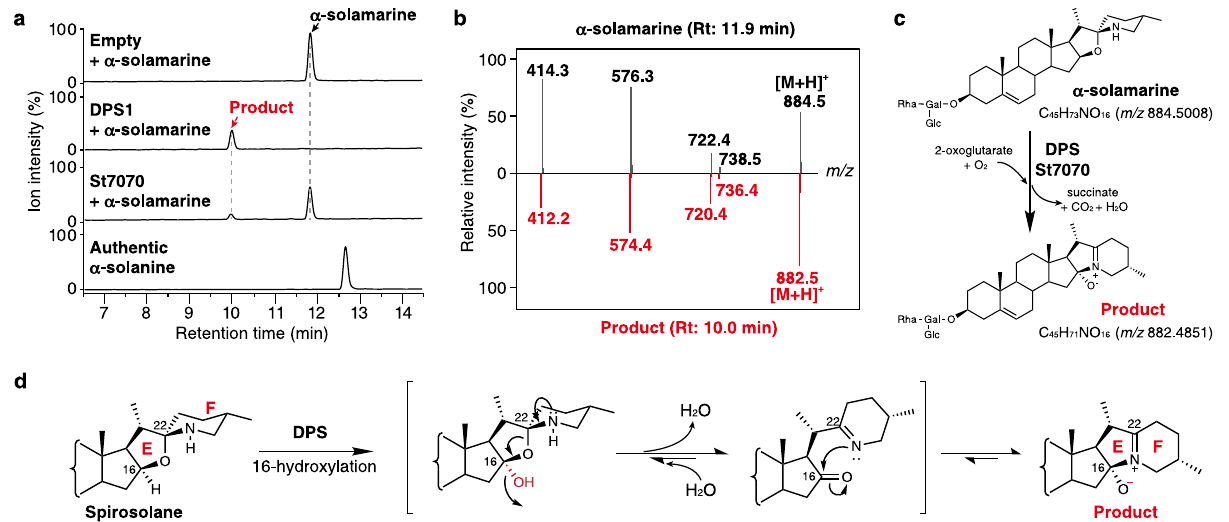
Fig. 4 The enzymatic activity of DPS and St7070. a LC – MS analysis of the reaction products from the recombinant DPS and St7070 proteins with α - solamarine as a substrate. Total ion current (TIC) chromatogram obtained in positive ionization mode with a full-scan range of 350 – 1250 m/z are shown. The negative control reaction was performed using a puri fi ed protein fraction from E. coli cells transformed with an empty pCold ProS2 vector. b Mass spectrum of the peaks at a retention time of 11.9 min (substrate, α -solamarine) and 10.0 min (reaction product). MS fragmentation pathways are shown in Supplementary Fig. 9. c Enzymatic reaction DPS or St7070. d Putative reaction mechanism of DPS or